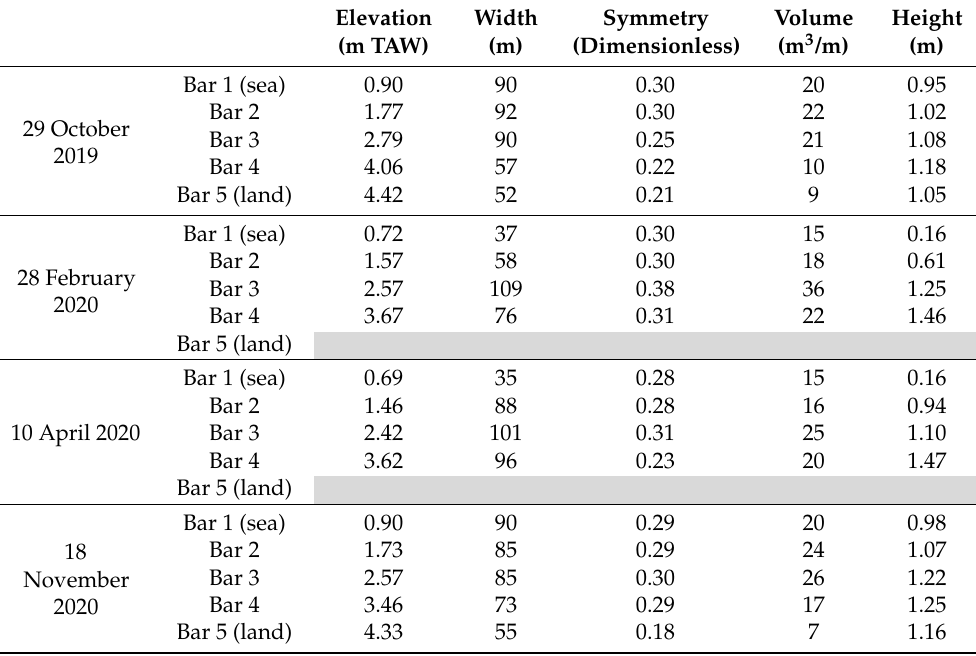
Table 3. Summary of averaged bar parameters across the profiles for pre- and post-storm surveys. Elevation (m